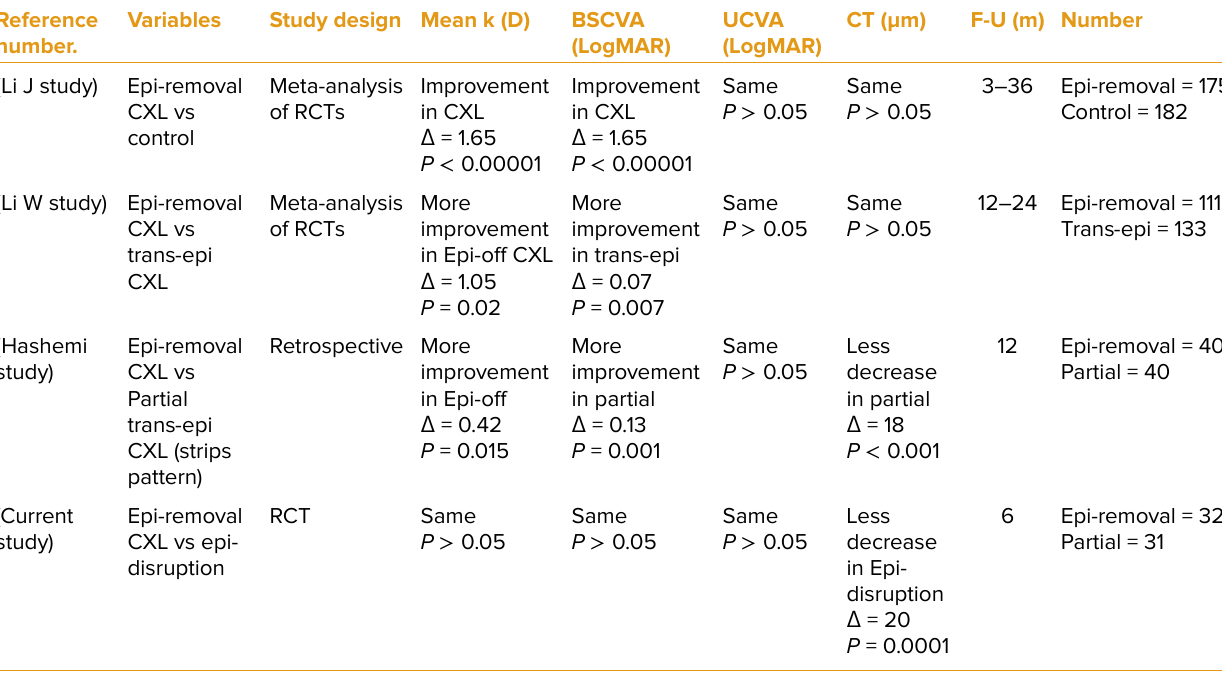
Table 3. Comparison of epithelium removal CXL with other CXL modifications Reference